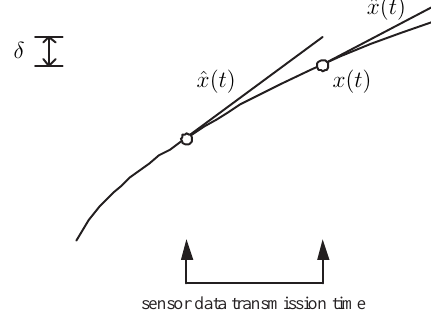
Figure 2 . Send-on-delta transmission with a linear